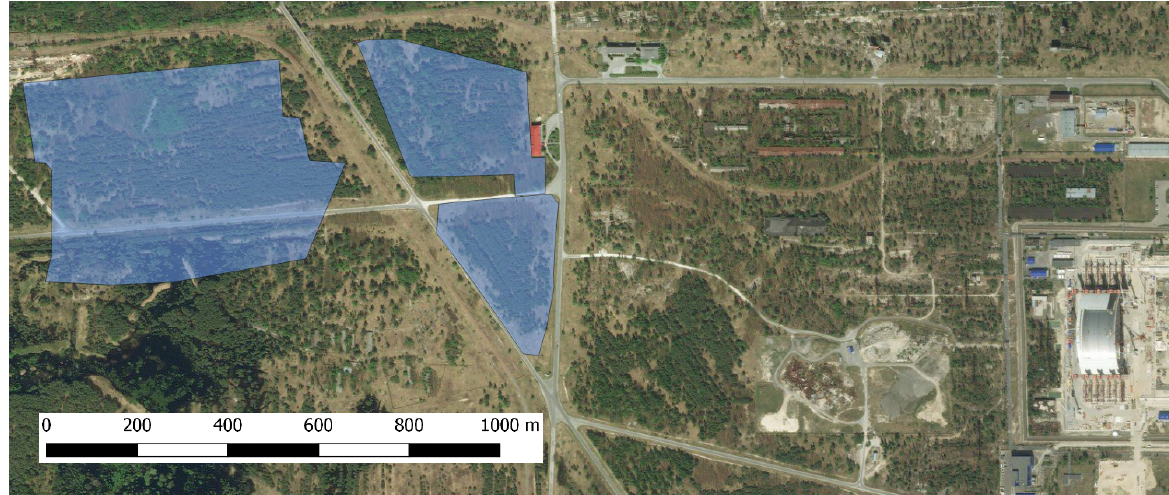
Figure 1. Overview of the study area, located around 1.5 km west of the ChNPP (base map source: bing map ©Microsoft